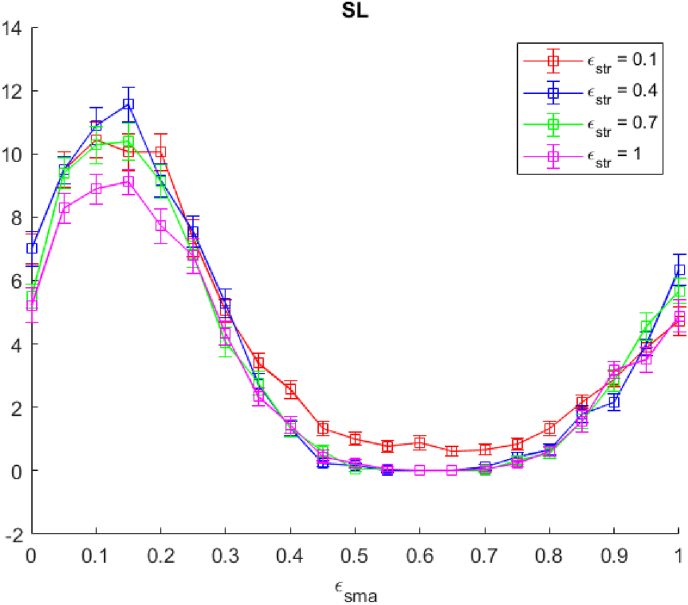
Set Loss errors as a function of εsma, for four different values of εstr. Consistent with Fig. 16, set loss errors are largely independent of εstr, but are high at extreme values of εsma. When εsma is between 0.45 and 0.75 set loss errors are negligible except at very low values of εstr. Error bars show one standard error from the mean.